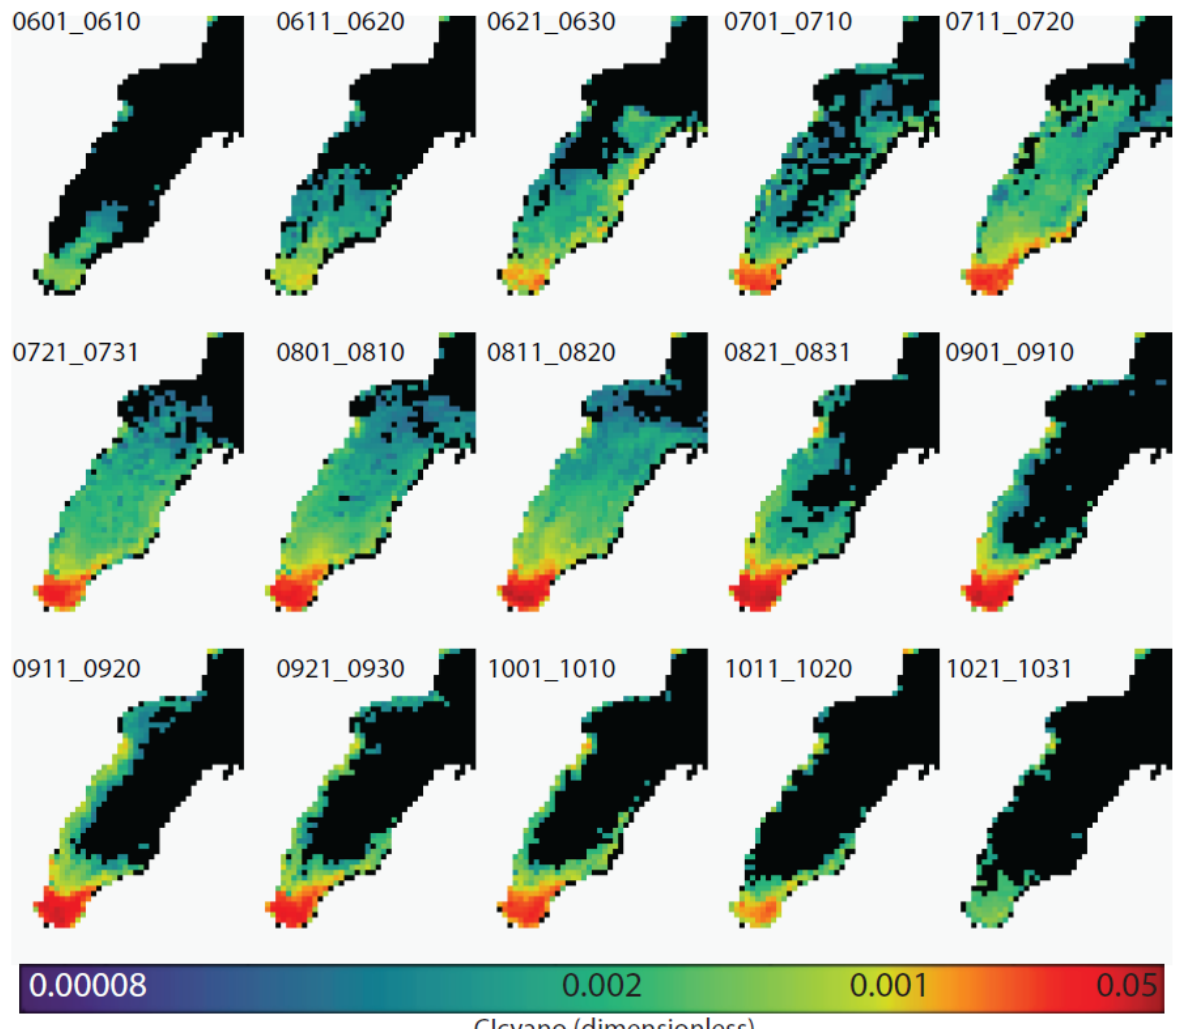
Figure 5. Shows the 15 climatological means from the CI cyano 10-day composites. These were con- structed over the 10-year MERIS timeseries from 2002 – 2011 between June and October. Warmer colors indicate higher cyanobacteria biomasses, while cooler colors indicate lower cyanobacteria biomasses. Table 2. The 10-day composite periods (dates in parentheses) exhibiting the highest mean, median, and mode integrated CI cyano values during the 10-year MERIS time series. Details on how values were calculated are given in Section 2.4.